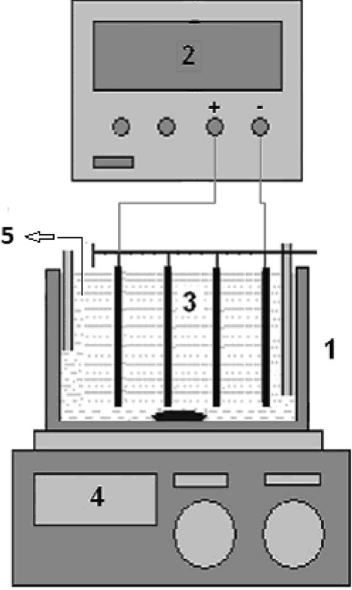
Fig. 1 Schematic diagram of experimental setup (1: electrocoagula- tion cell, 2: dc power supply, 3; bipolar electrodes, 4: magnetic stir-